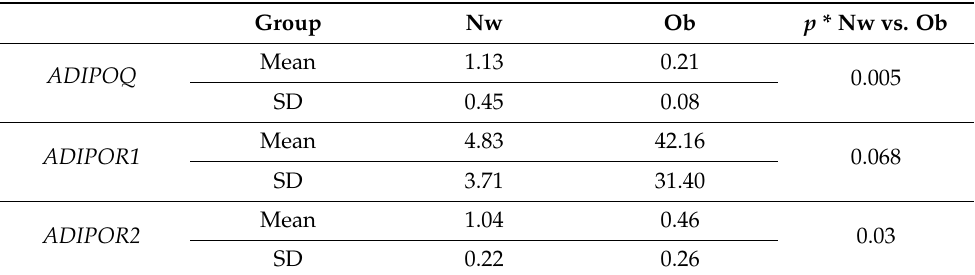
Table 3. Mean mRNA levels and standard deviation values (SD) of ADIPOQ and its receptors ( ADIPOR1 , ADIPOR2 ) in normal weight and obese skin